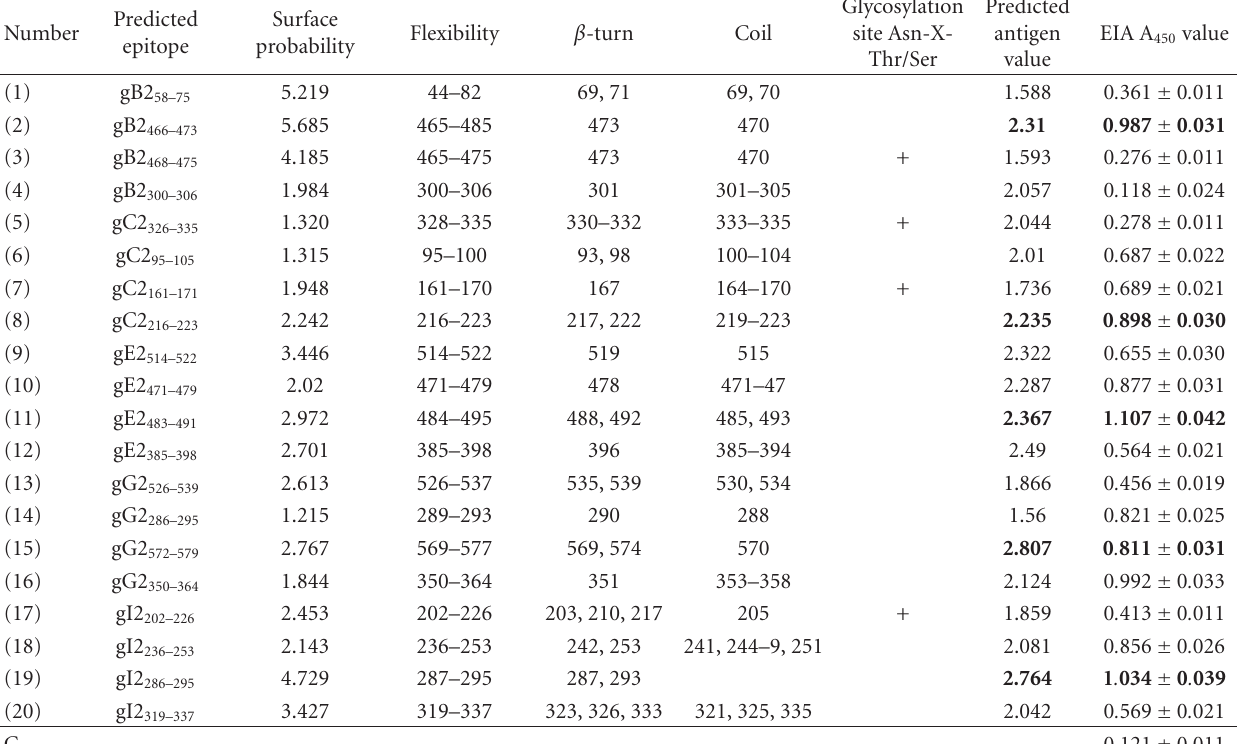
Table 1: Predicted antigenicity (antigen value) of the 20 epitopes and the EIA detection results.